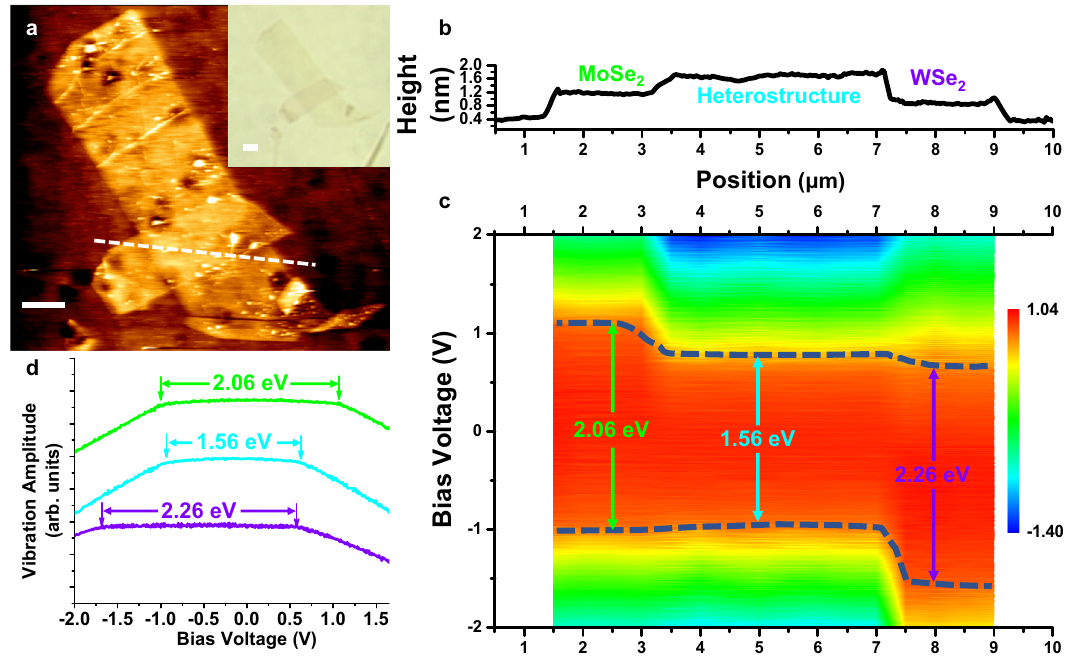
Fig. 4 | LEFM measurement on van der Waals heterostructures. a AFM topo- graphy mapping of the MoSe 2 /WSe 2 van der Waals heterostructure. Inset is the opticalimage of the same sample(scale bars: 2 μ m). b The height pro fi le along the white dashed line in ( a ). c The band edge pro fi le of the heterostructure along the white dashed line. The band gapsatthe corresponding positions in( b ) are marked